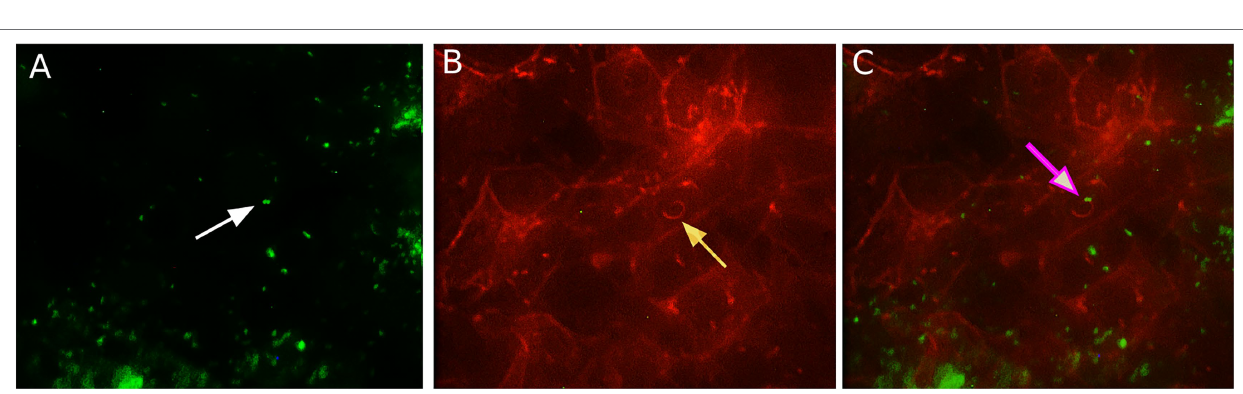
FIGURE 3 | The association of Listeria monocytogenes with F-actin in shKEC cells. (A) Listeria monocytogenes conjugated with antibodies in the shKEC cells; the white arrow points to a bacterial cell. (B) Cytoskeleton of shKEC cells infected with L. monocytogenes and F-actin labeled with phalloidin; the yellow arrow points to a cytoskeleton rearrangement. (C) This part combines (A,B) . The pink arrow indicates the area of actin polymerization associated with bacteria cells. The samples were captured with an Axio Scope A1 fluorescence microscope at 1,000× magnification in three independent